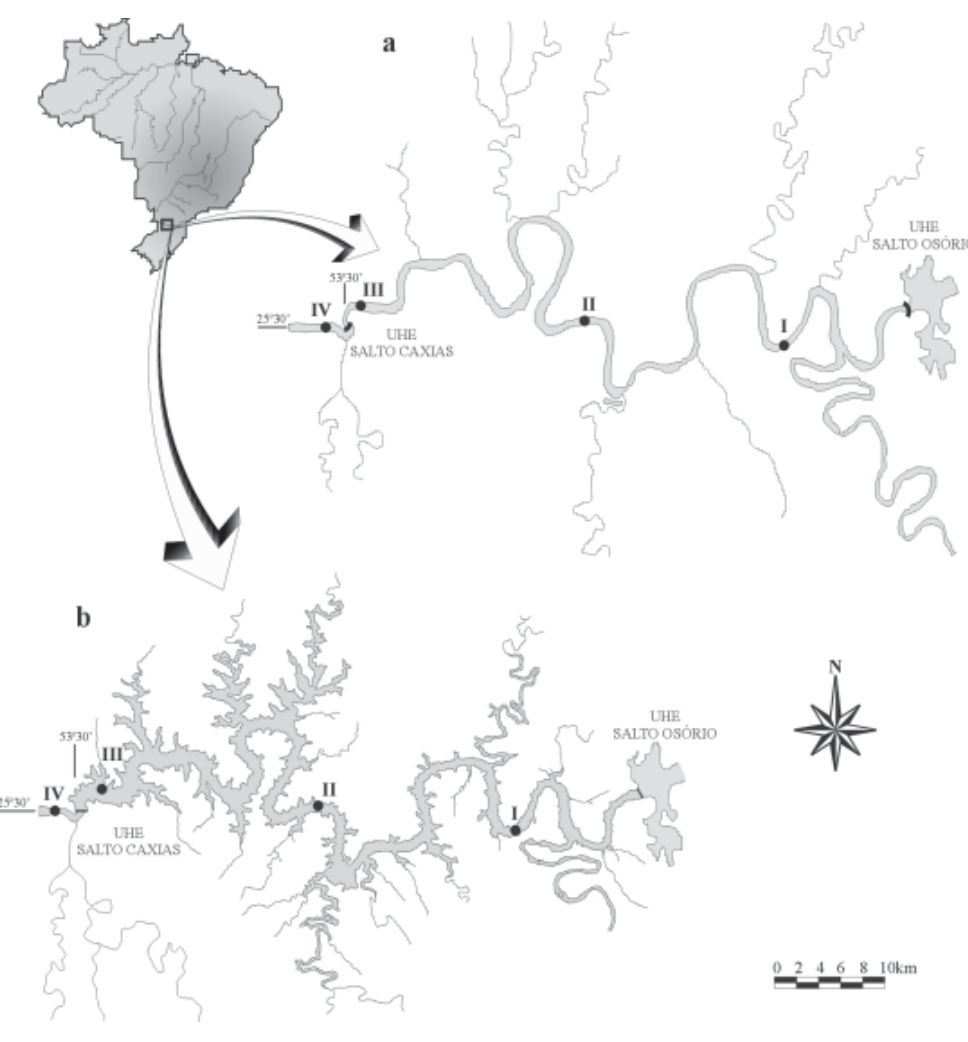
Fig. 1. Map of the studied area. Iguaçu river (a) and Salto Caxias reservoir